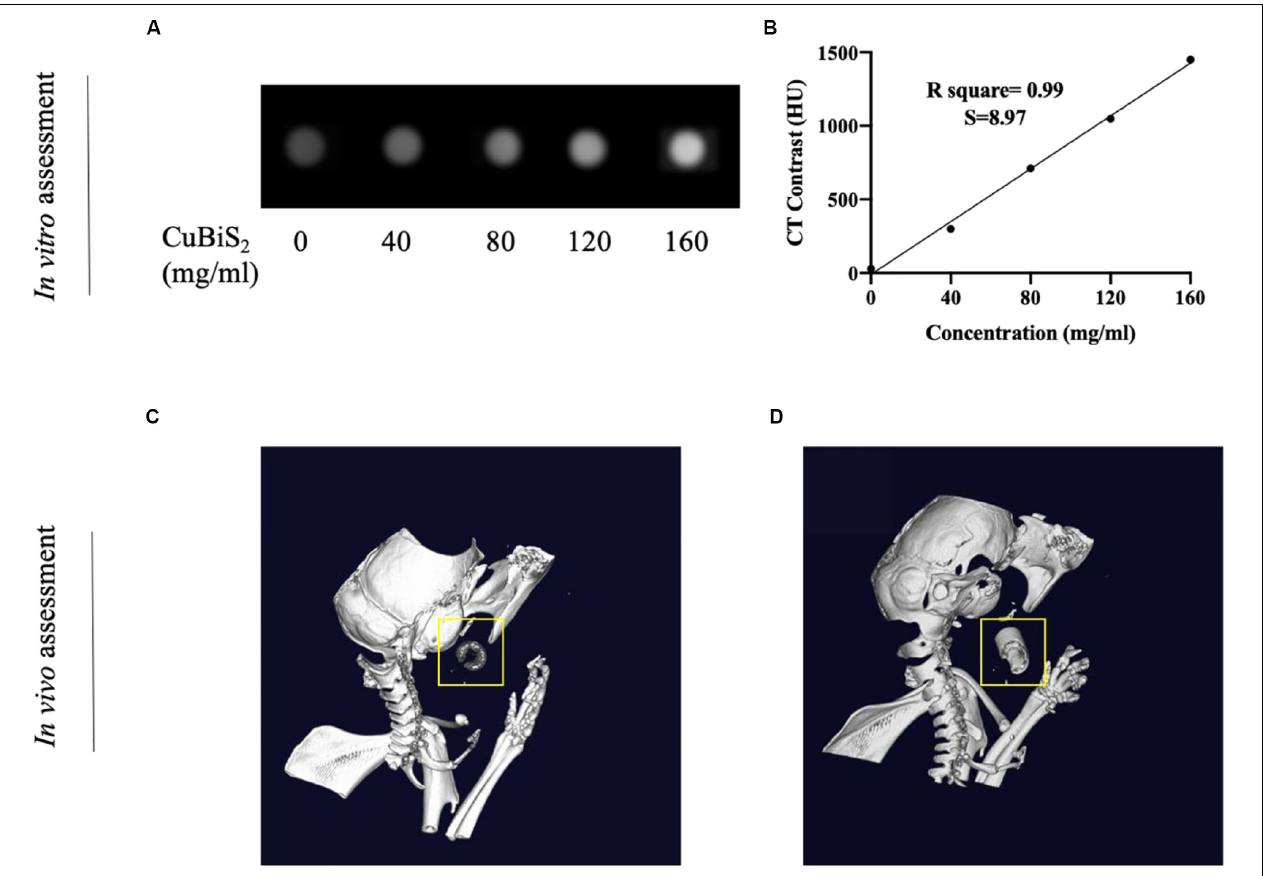
FIGURE 6 | Demonstration of computed tomography imaging property of CuBiS 2 in vitro and in vivo . (A) The CT signals intensity of different CuBiS 2 concentration in vitro . (B) CT value (HU) of the CuBiS 2 NPs as a function of the concentration of NPs. (C,D) 3-D CT imaging of mice without and with CuBiS 2 NPs being injected to the surrounding of the carotid artery, respectively.